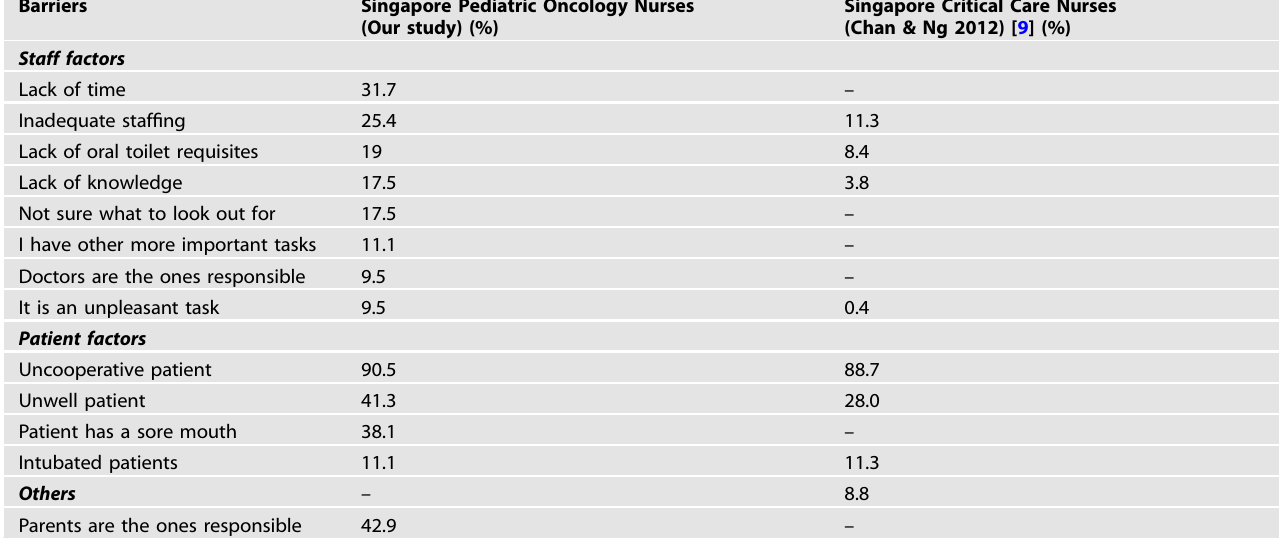
Table 3. Responses to “ Barriers that hinder me from performing oral care for the patients ” , compared to a similar previous study #